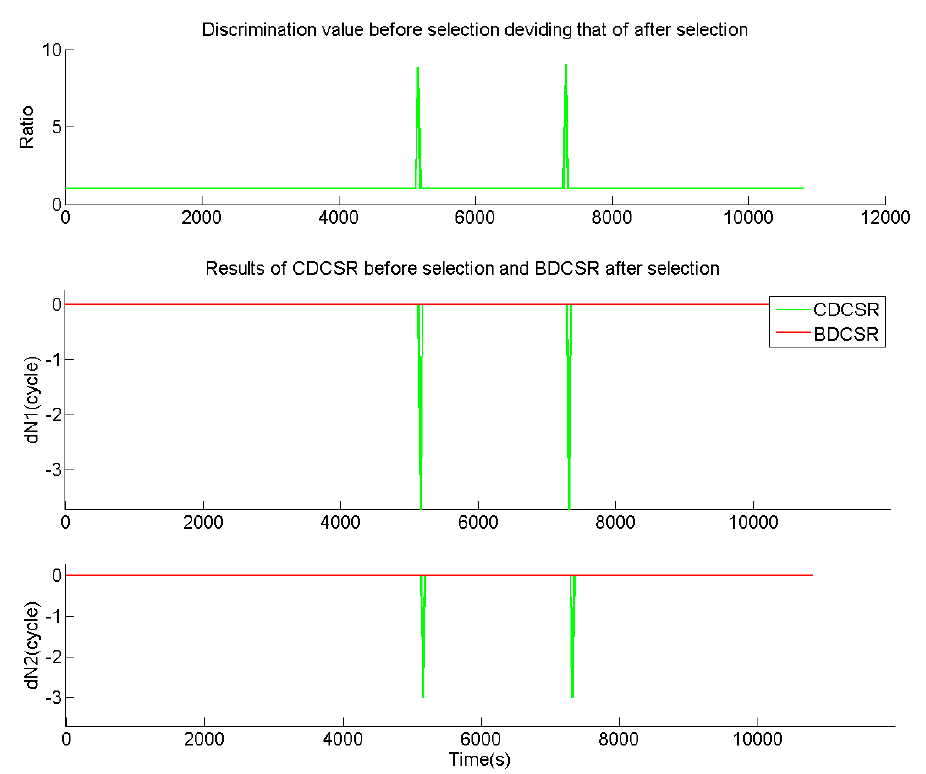
Figure 8. Results of CDCSR before selection and BDCSR after selection with the discrimination function from the GEO Satellite 2 under a fine condition with the medium elevations during the geomagnetic storm, where the phase data without cycle slip was collected at the CUT0 station started from UTC 8 May 2016 00:00:00 with an interval of 30 s.